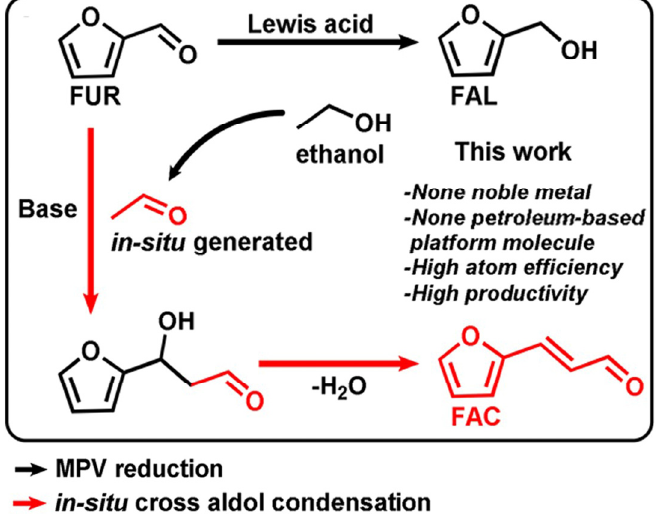
Figure 8. An integrated process combining MPV reduction with in situ cross-aldol condensation for the upgrading of furfural in ethanol to FAL and C7. Reproduced with permission from [33]. Copyright: American Chemical Society